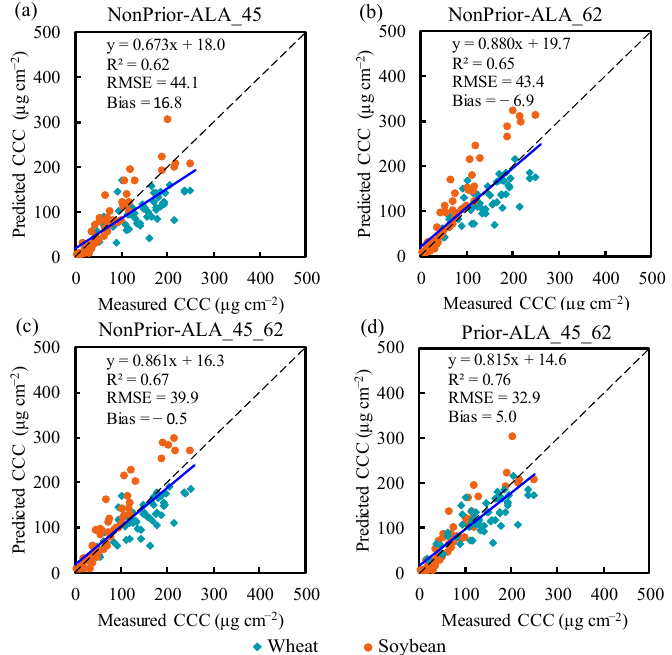
Figure 4. Scatter plots of the ground-measured CCC and the CCC predicted by ground-measured canopy spectra, based on the RFR models ( a – c ) without and ( d ) with prior ALA adj knowledge related to crop types. ( a ) NonPrior-ALA_45 mode; ( b ) NonPrior-ALA_62 model; ( c ) NonPrior-ALA_45_62 model; ( d ) Prior-ALA_45_62